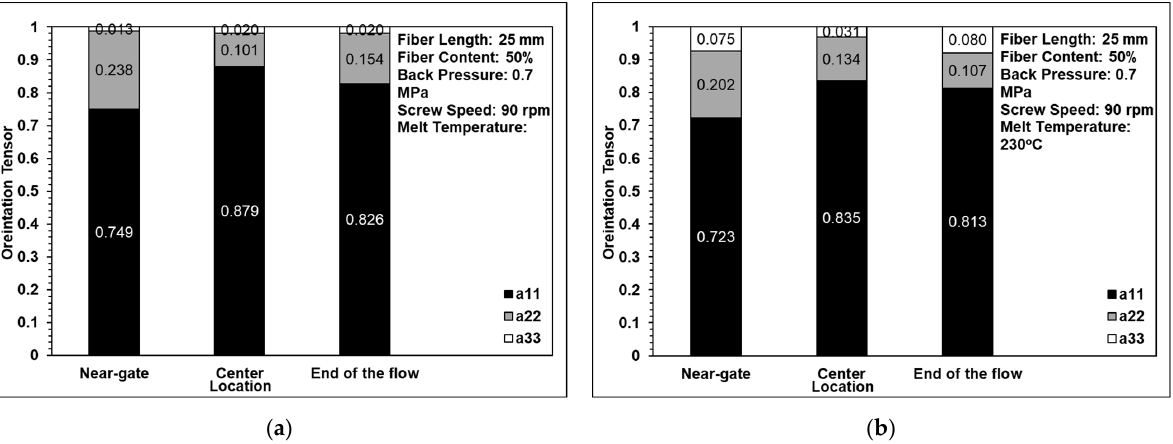
Figure 9. Comparison of the orientation tensor in ( a ) computed tomography and ( b ) optical micros- copy images of a single-sprue